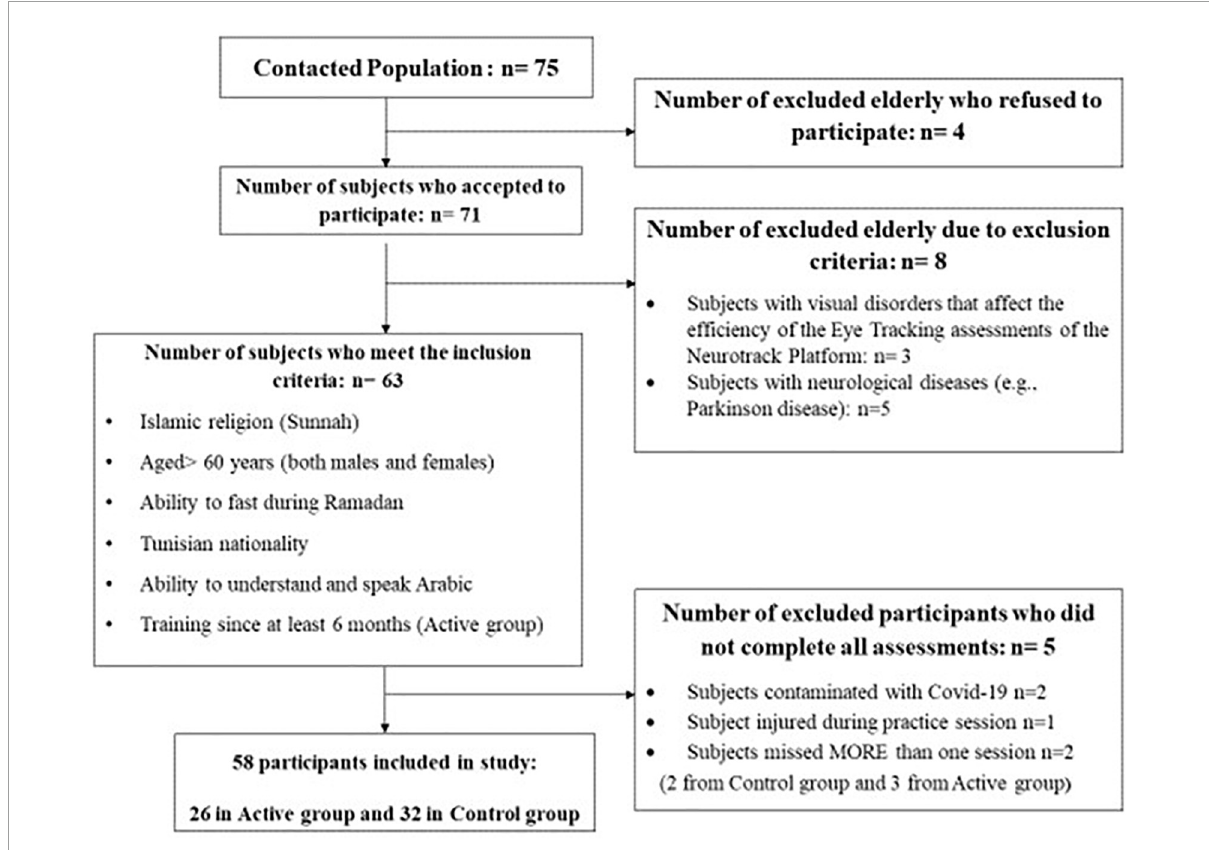
FIGURE1 Flowchart outlining the selection criteria and decision-making process for the elderly who participated in the ongoing assessments.